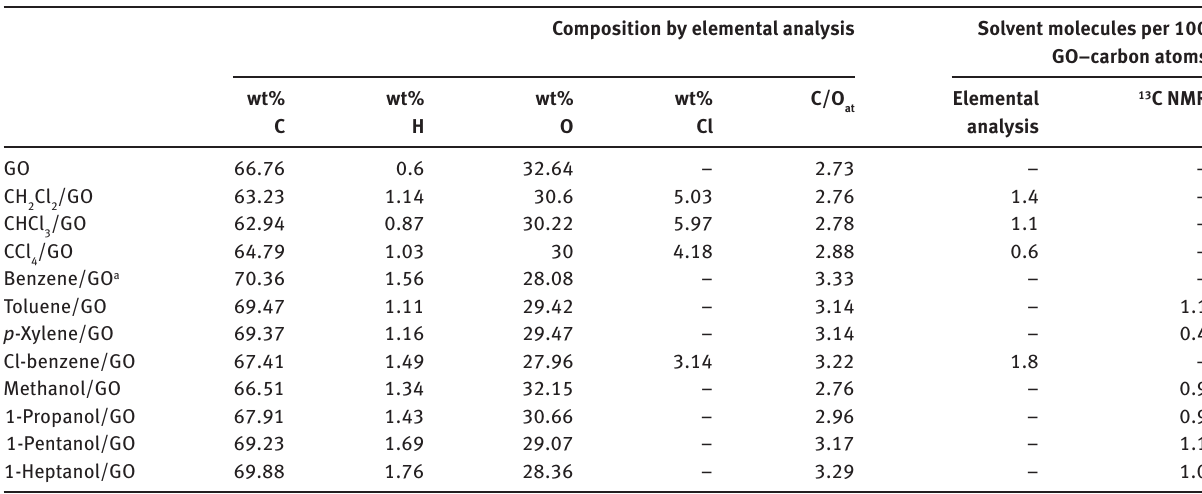
Table 1: Composition of nontreated GO and retained-solvent/GO by elemental analysis quantification of the adsorbed solvent molecules per 100 GO–carbon atoms by elemental analysis and 13 C NMR [38].